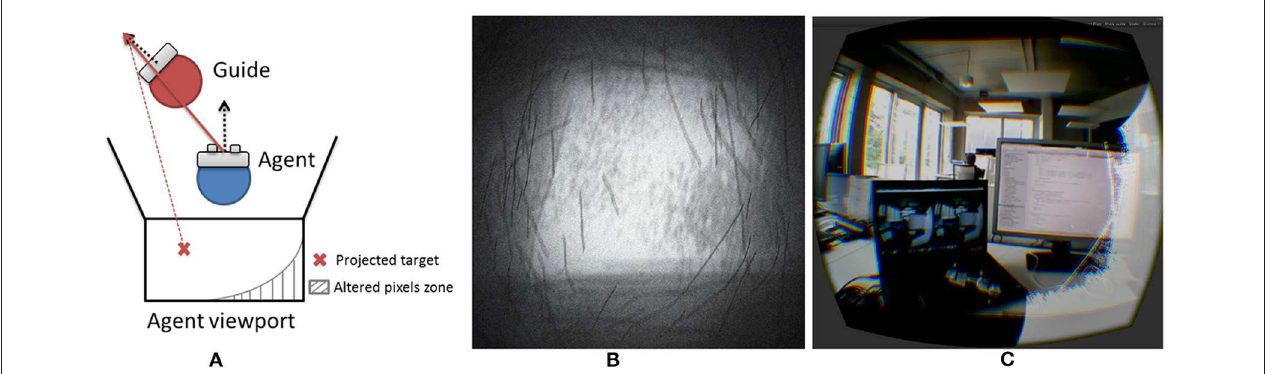
FIGURE 11 | (A) Principle of the guiding extension to improve final precision (top view); (B) noisy reticule texture used to alter pixels within the guiding shader; (C) illustration of the guiding shader performing as an extension of the stretchable guiding arms. The white zone is the alteration zone, indicating here that the guide is looking to the left and is a little higher than the current follower’s viewpoint.